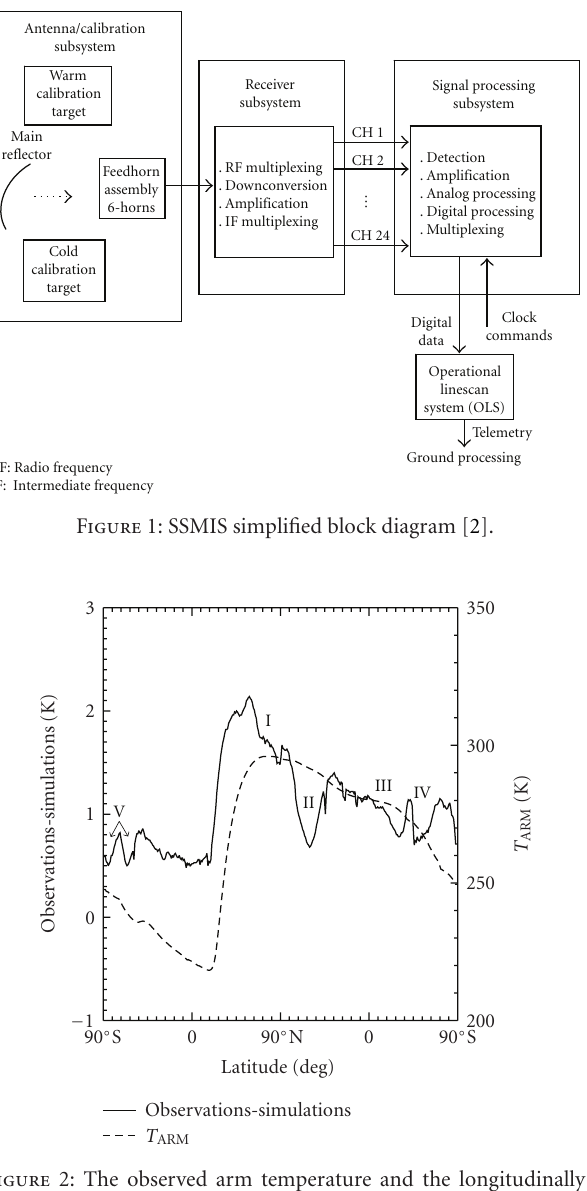
Figure 2: The observed arm temperature and the longitudinally antenna temperature di ff erences at 54.4GHz between the SSMIS TDR measurements and radiative transfer simulations, on March 20, 2005, where the results from 90 ◦ S to 90 ◦ N correspond to the ascending node observations and those from 90 ◦ N to 90 ◦ S correspond to the descending node